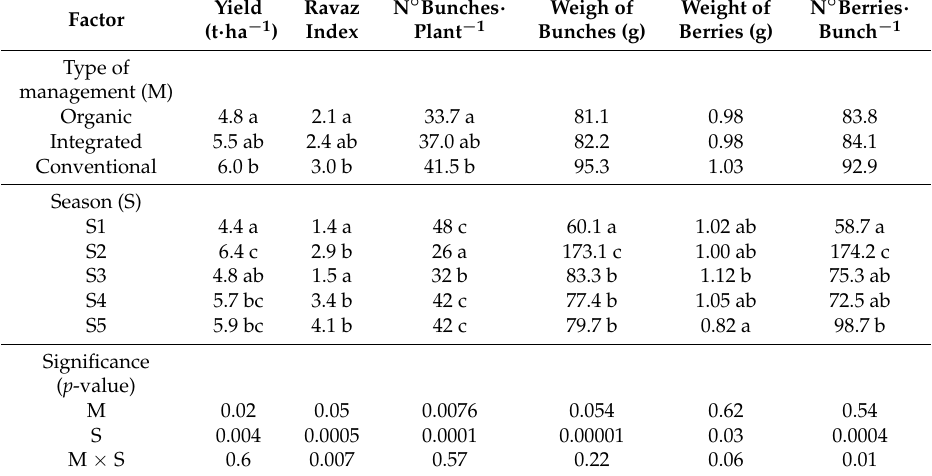
Table 2. Effect of organic, integrated and conventional management on yield (t · ha − 1 ), Ravaz index, and yield components such as number of bunches per plant, weight bunches, weight of berries and number of berries per bunch in Cabernet Sauvignon grapevines evaluated during 5 consecutive